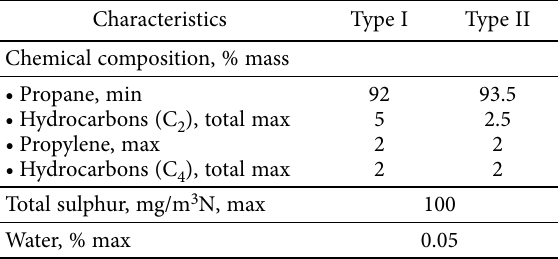
Table 2. The chemical composition of propane, Type I and II